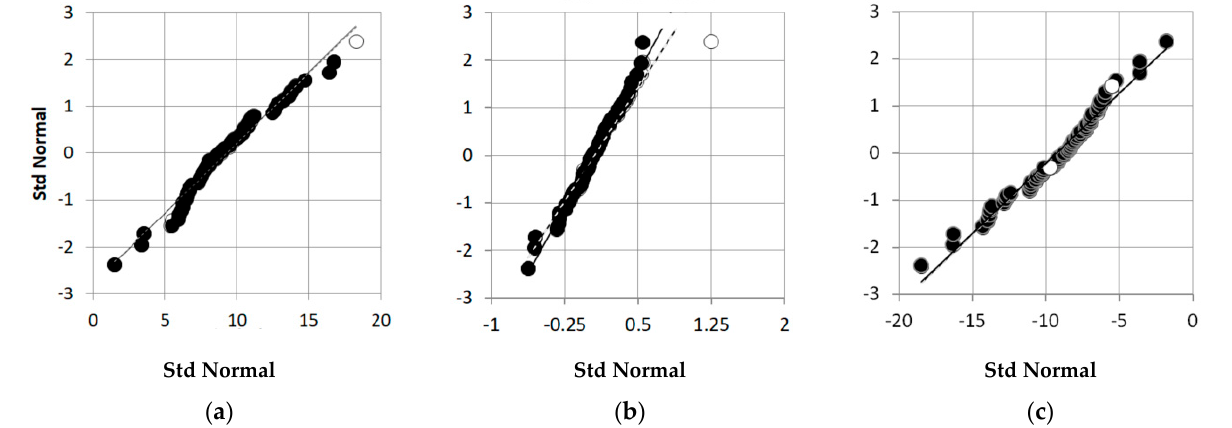
Figure 7. Q–Q plots for the ( a ) GE-CTN, ( b ) GNSS-CTN, and ( c ) GNSS-GE Δ h pairs: before outliers’ removal (white dot) and after outliers’ removal (red dots overimposed). The trend lines before and after candidate outliers’ removal are represented with dashed and continuous lines, respectively.